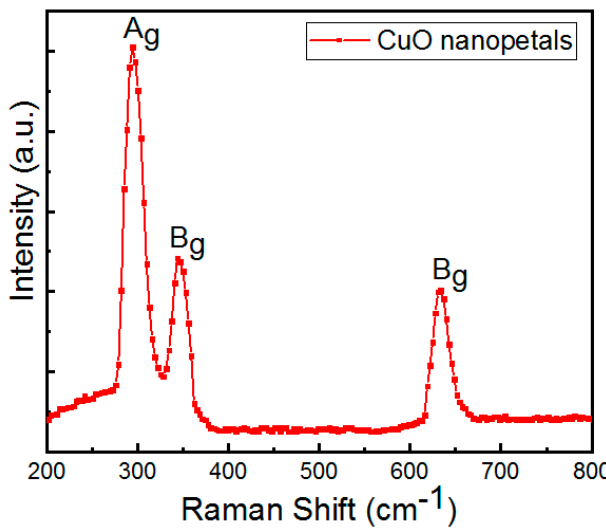
Figure 4. Raman analysis of CuO nanopetals synthesized by simple hydrothermal at 110 °C for 3 h.